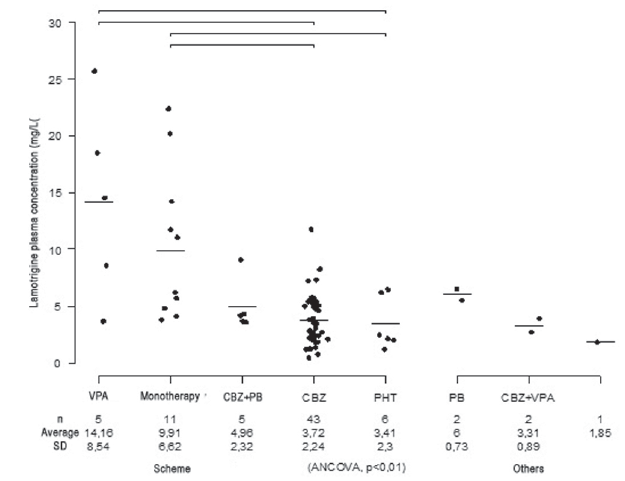
FIGURE 2 - Comparisons among the mean LTG plasma concentrations considering the specific therapeutic schemes taken by the adult patients with refractory epileptic seizures (n=75). (VPA: valproate; CBZ: carbamazepine; PB: phenobarbital; PHT: phenytoin; SD: standard deviation). Horizontal lines at the top of the graph indicate pairwise significant differences between the